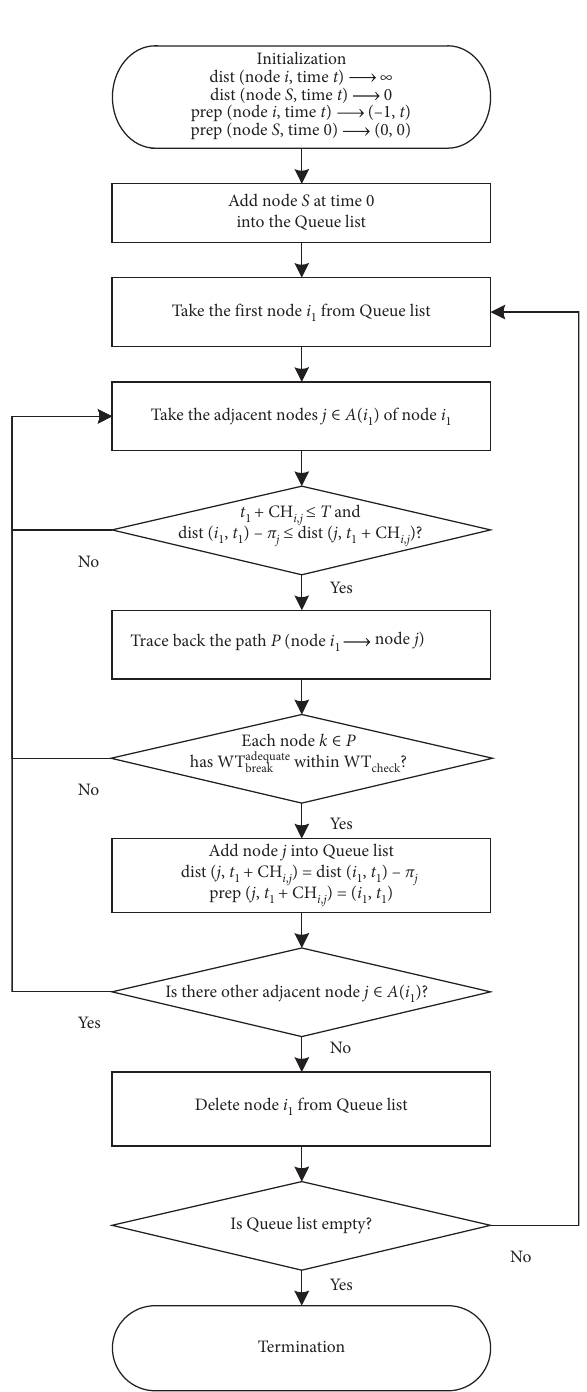
Figure 6: Flow chart of the constrained shortest path